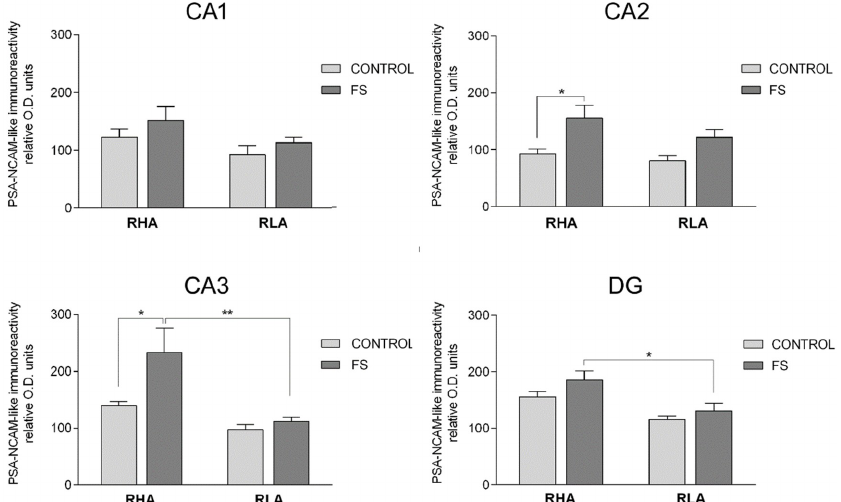
Figure 8. Densitometric analysis of the PSA‐NCAM‐like immunoreactivity in the CA1–CA3 sectors of the Ammon’s horn and in the dentate gyrus (DG) of the dorsal hippocampus, in baseline conditions (CONTROL) and after forced swimming (FS). Columns and bars denote the mean ± S.E.M. of six rats, in each experimental group. Two different sections were analyzed for each rat. *: p < 0.05; **: p < 0.01 (Tukey’s post hoc test or Sidak's correction for multiple comparisons).